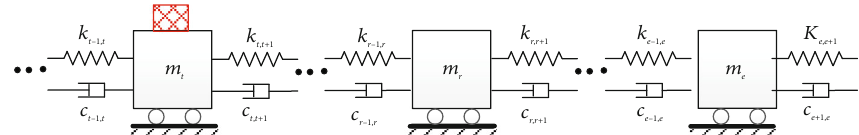
Figure 1: Damped spring-mass system with n DoFs modi fi ed by